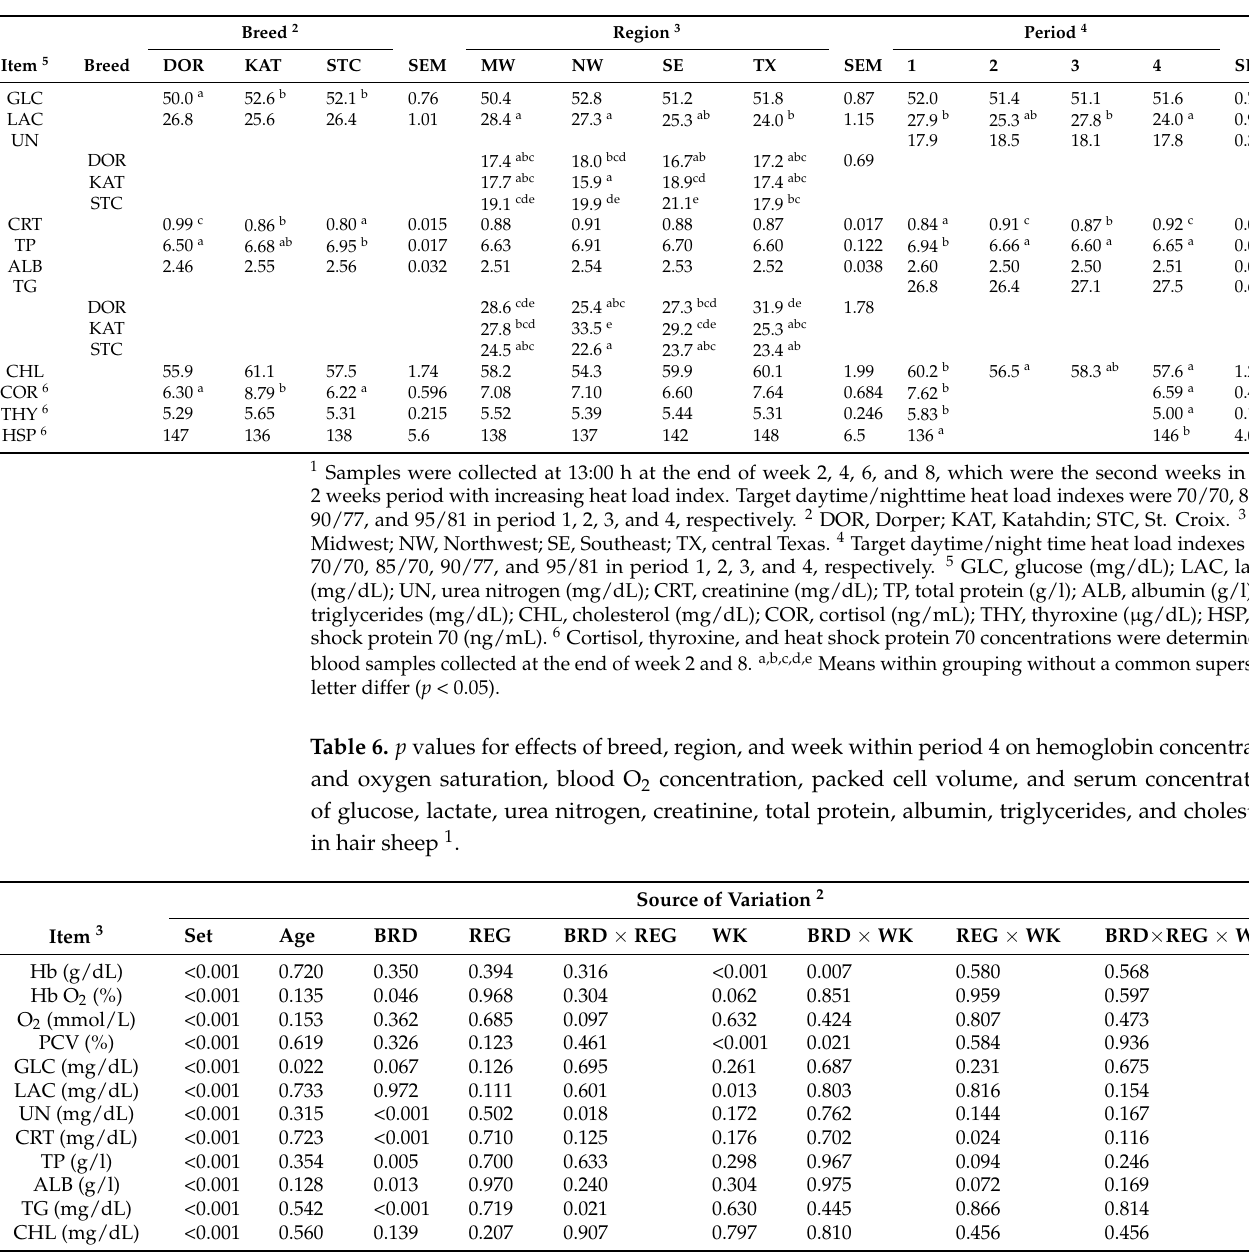
Table 5. Effects of breed, region, and period with different heat load indexes on serum concentrations of glucose, lactate, urea nitrogen, creatinine, total protein, albumin, triglycerides, cholesterol, cortisol, thyroxin, and heat shock protein 70 in hair sheep 1 .